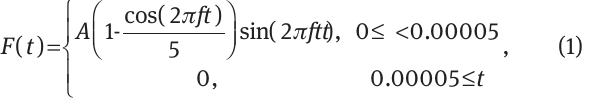
Table 2: Element size and convergence study for undamaged beam. Element size (mm)